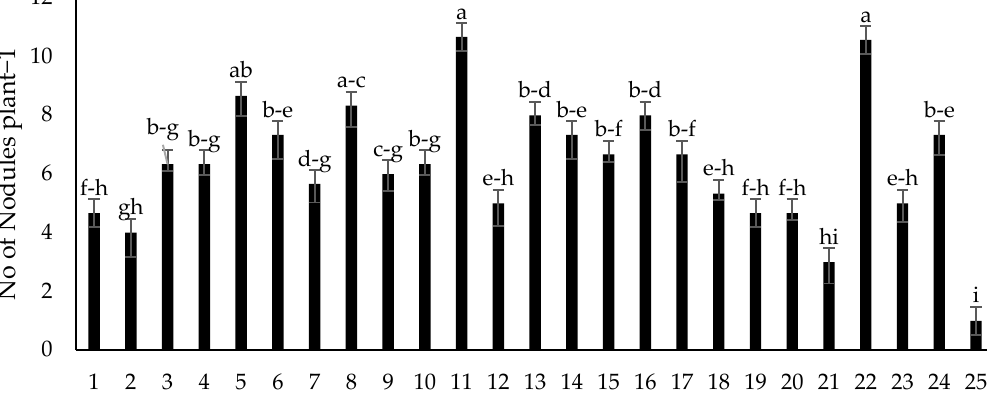
( B ) Enterobacter cloacae -RP08, ( C ) Providencia vermicola -RS15.